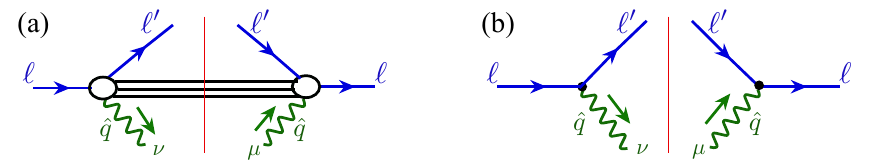
Figure 13 . Sketch for sample scattering amplitudes of SIDIS with (a) one-photon exchange, and (b) one-gluon exchange.